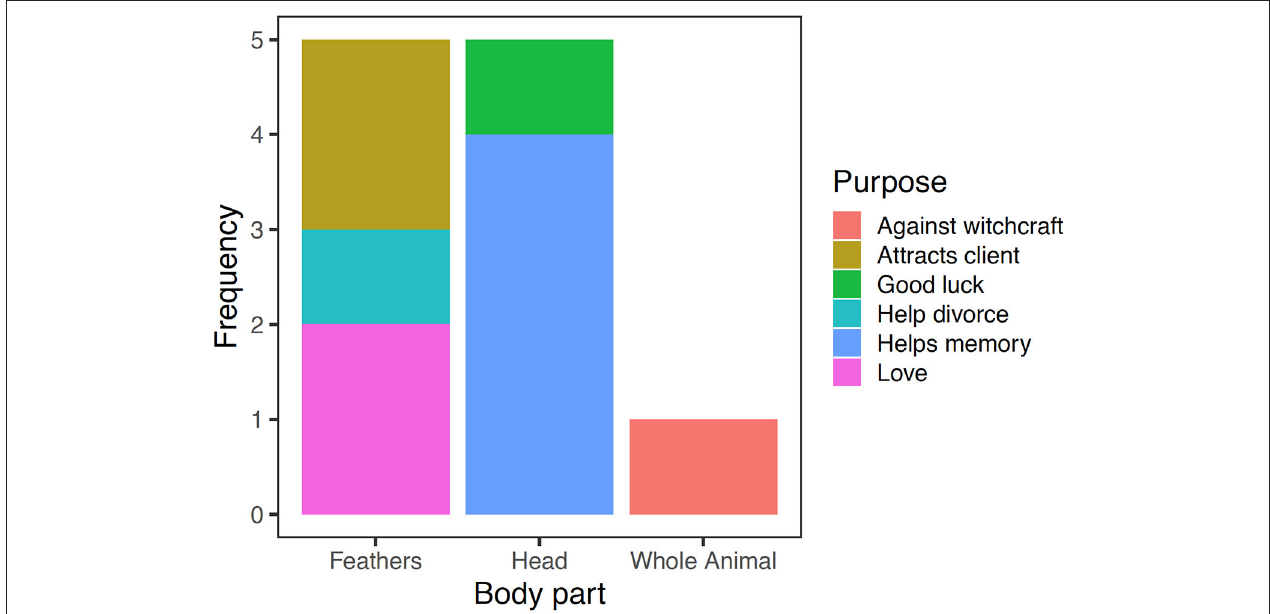
FIGURE 2 | Frequency of cited Grey parrot ( Psittacus erithacus ) purposes (both medicinal and spiritual) and body part